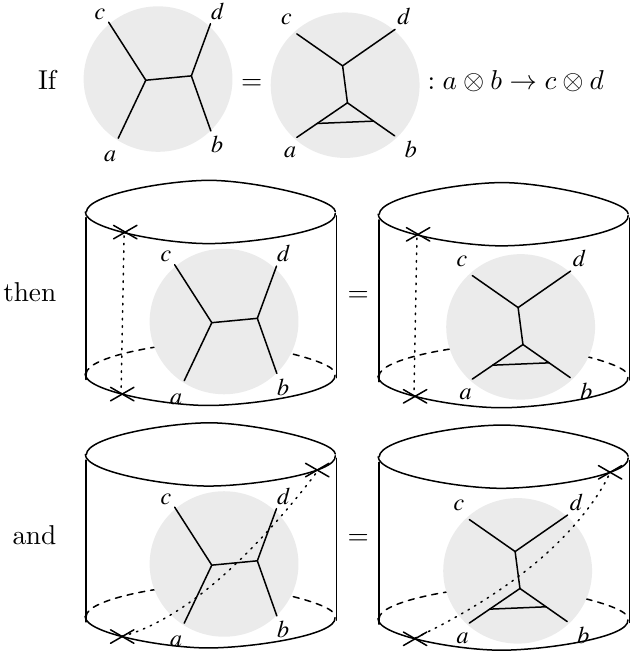
Figure 35 . A local change in the network should not a(cid:11)ect the map on the Hilbert space if the two subnetworks give the same